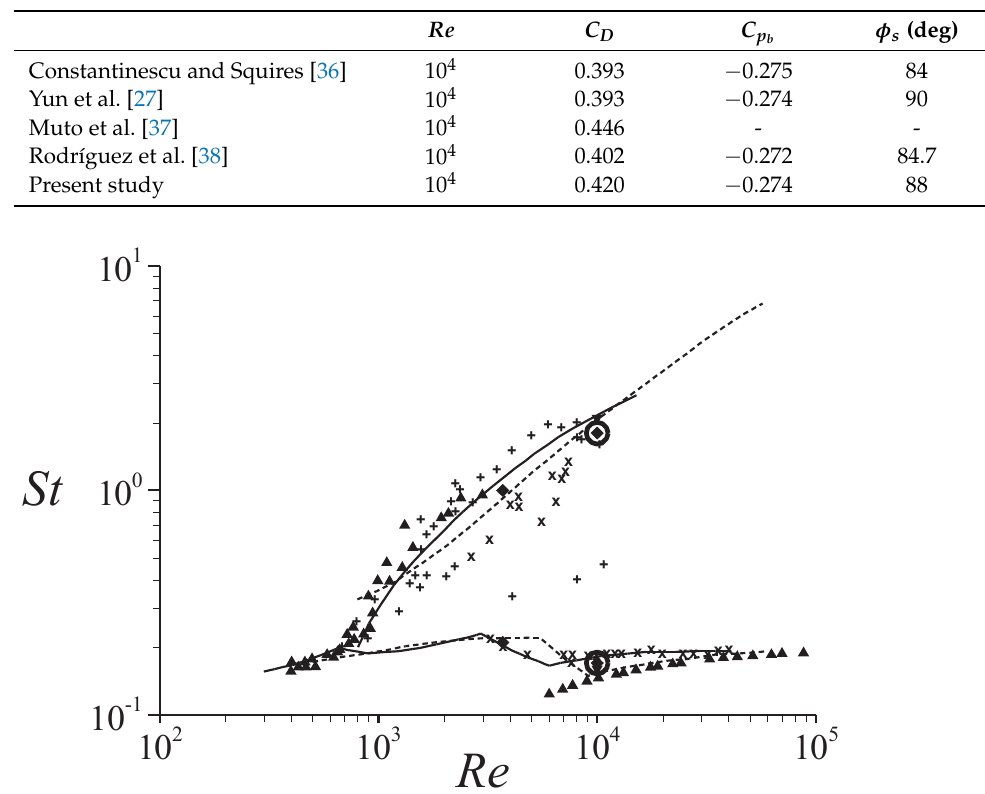
Table 1. Flow statistics of the uncontrolled flow over a sphere at Re = 10 4 from the present simulation together with those from previous studies.